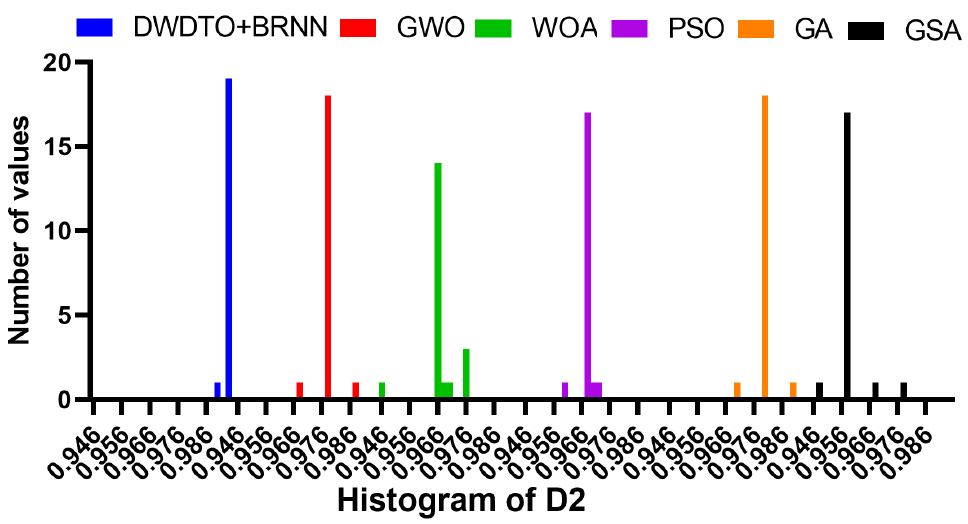
Figure 12. Histogram of the accuracy achieved by the proposed approach and other optimization approaches in terms of the second dataset (D2).